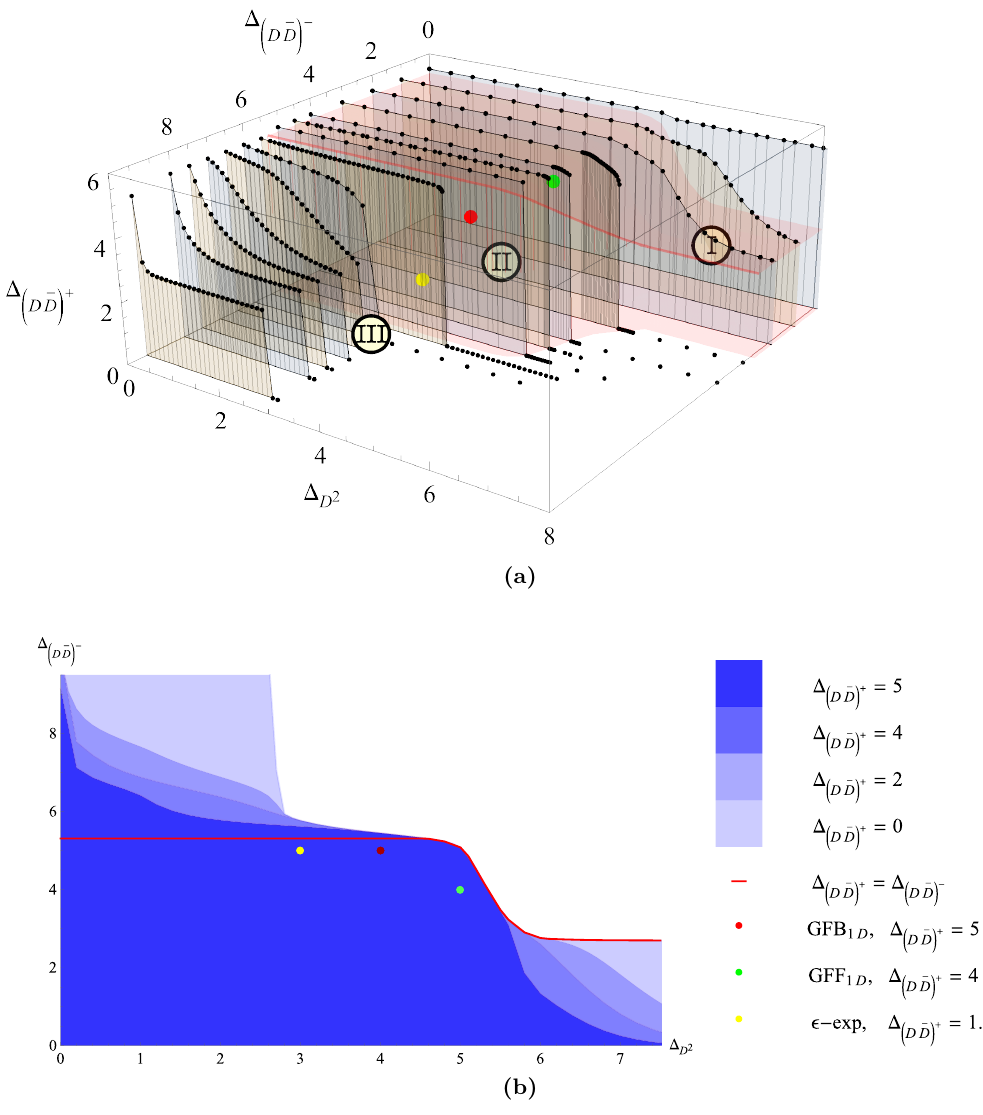
Figure 1. (a) Upper bounds on the dimension of the S -parity even scalar ( D ¯ D ) + as a function of the S -parity odd operator ( D ¯ D ) − and the leading charged operator D 2 . (b) Projection of the three- dimensional allowed region in the (∆ , ∆ ) plane for different values of ∆ . All points D 2 ( D ¯ D ) + ( D ¯ D ) − are computed with Λ = 33 , P = 53 . The green and red dots correspond to the GFF and GFB solutions respectively. The yellow dot is the extrapolation to ε = 1 of the ε -expansion predictions for the magnetic line defect. The solid red line in (b) is the ‘agnostic’ bound for ∆ = ∆ ( D ¯ D ) + ( D ¯ D ) −